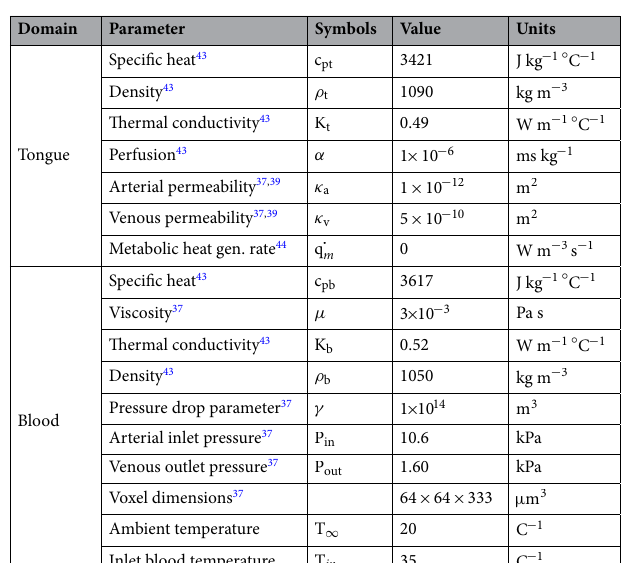
Figure 3. ( a ) Original frog tongue data with arteries in red and veins in blue. The number of pixels in original 2D data are 634 × 515, with pixel dimensions as 0.063 mm × 0.064 mm × 1 mm. The slice was modified for generating three slices each one-third the thickness as follows. ( b ) Layer 1: Arterial tree and tissue. ( c ) Layer 2: Tissue. ( d ) Layer 3: Venous tree and tissue. Filled triangle—Arterial tree root nodes with Dirichlet boundary condition. Filled inverted triangle—Venous tree root nodes with Dirichlet boundary condition.